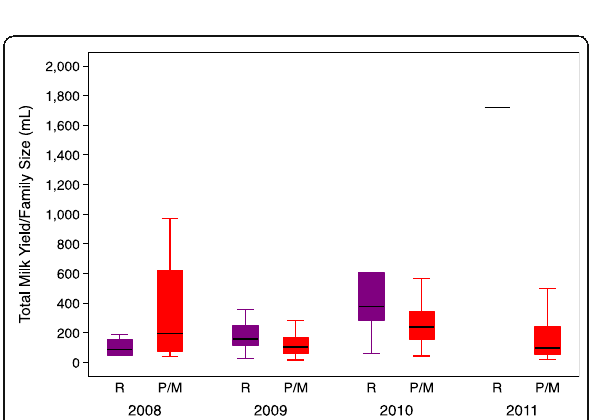
Figure 18 Total actual milk yields available per capita for all four years of the current study ( n =31 families). R indicates ‘ rich ’ households and P/M indicates ‘ poor and middle class ’ households. Data is plotted by year from 2008 to 2011. Yields are low for all four years among poor/ middle class families, with individuals having access to approximately 200 ml per day. Milk yields only significantly improve for the rich in the years following the drought (2010 to 2011). Low sample size in 2011 among rich families did not allow for enough variation to calculate accurate standard error around the mean. Reported as (mean +/- standard error) in the text